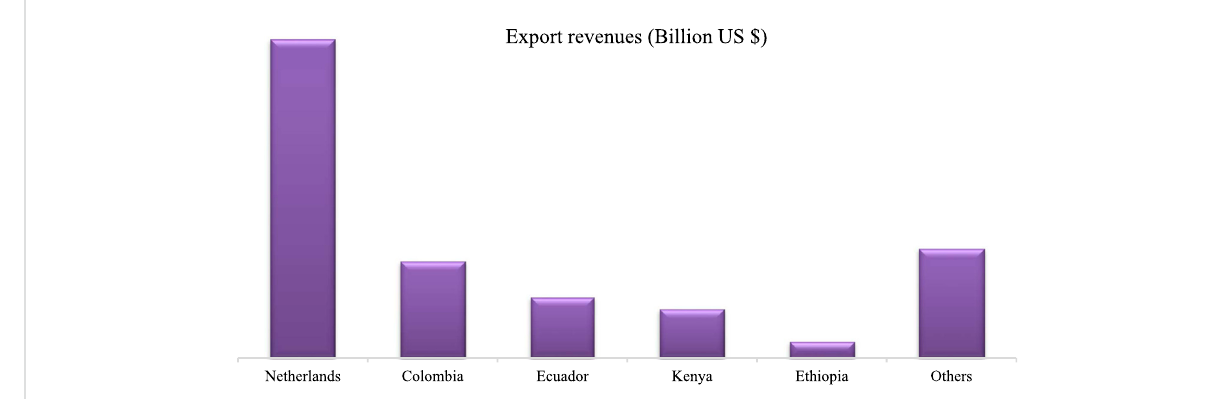
FIGURE 1 Top fi ve countries by fl ower export revenues and shares in 2019. Petal Republic, 2022.